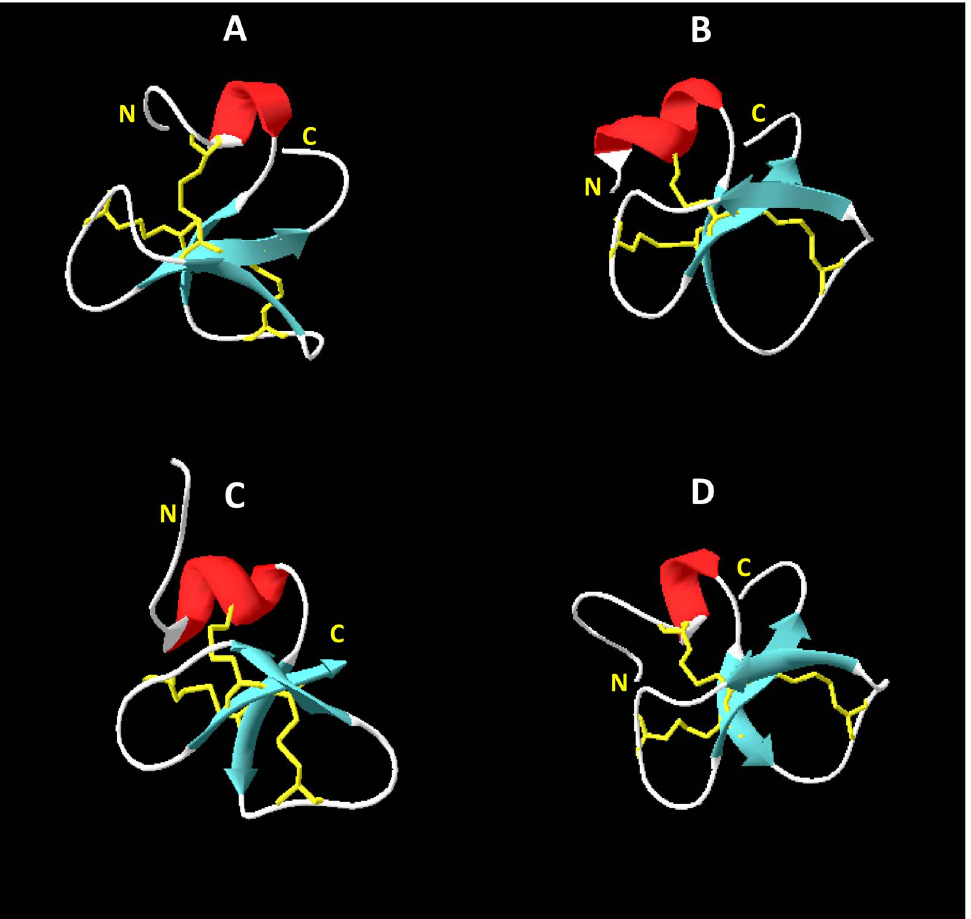
Figure 3. Three dimensional structures of cod Defb (A), crotamine (B), mBD8 (C) and zebrafish Defb1 (D). The presence of an a -helix (red), three antiparallel b -strands (blue), and the disulphide linkages of 1–5, 2–4 and 3–6 pattern (yellow) were found in all species. Homology modelling of cod Defb was performed using the PBD structure of crotamine, a neurotoxin from rattlesnake, Crotalus durissus trrificus (PDB ID: 1H5O), and mouse beta-defensin 8 (mBD8, PDB ID: 1E4R) as